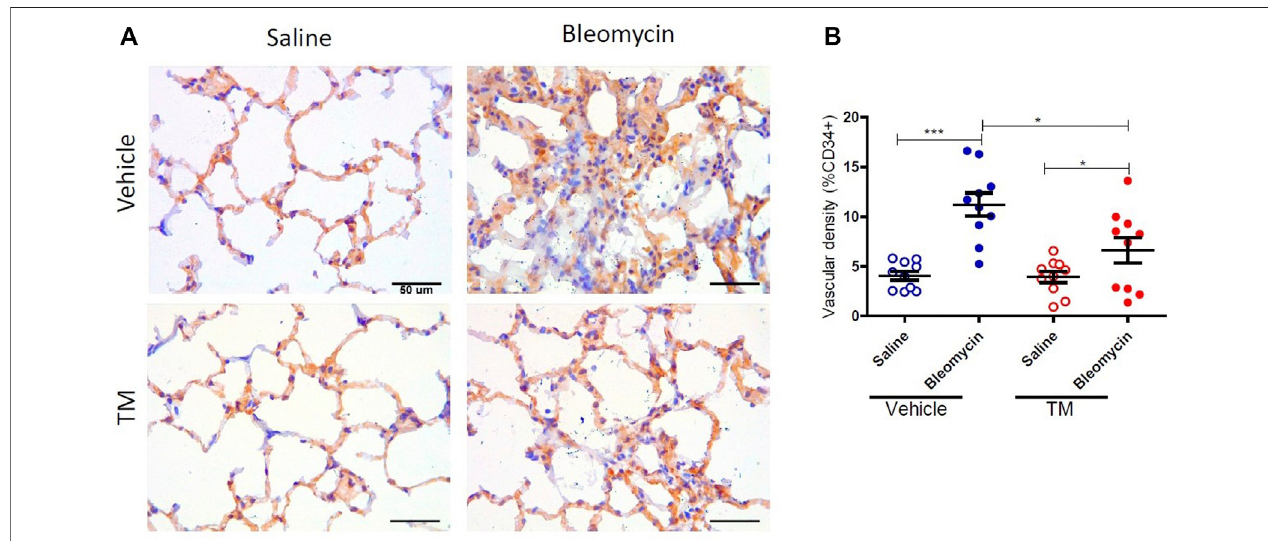
FIGURE 2 | Effects of tetrathiomolybdate on bleomycin-induced angiogenesis of CD34 positive capillaries. (A) Representative photomicrographs showing anti- CD34immuno-stainedlungtissuesectionsofsalineandbleomycin-infusedlungsegmentsfromeithervehicle(sterilesaline)ortetrathiomolybdatetreatedsheep.Ineach animal, one lung segment was infused with saline (left-side images) whereas the contralateral segment was infused with bleomycin (right-side images). (B) Shows the vascular density data ofdifferentially treated lung tissue segmentsofeither vehicle or tetrathiomolybdate treated animals. Signi fi cance was analyzed using a paired t -test between saline- vs . bleomycin-infused segments from the same animals and an unpaired t -test between segments from different animals (vehicle vs TM treated animals), * p < 0.05, *** p < 0.001, ( n (cid:1) 10 Sheep). Data represent mean ( ± SEM). Scale bars (cid:1) 50 µm.